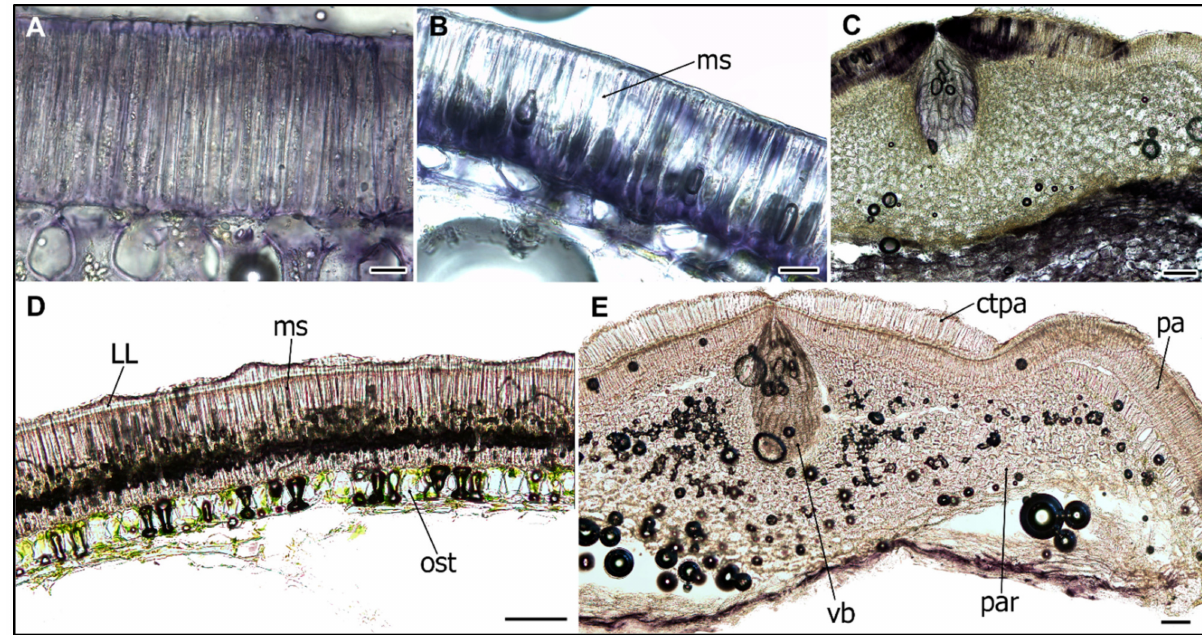
Figure 6. Histochemical localization of peroxidase activity in the pea seed coat. Cultivated pea ( Pisum sativum subsp. sativum ): cv. Cameor sampled at 13 DAA ( A ), and mature dry stage ( B ), hilum region at 25 DAA ( C ); wild pea ( Pisum sativum subsp. elatius ): JI1794 at 25 DAA ( D ) and hilum region of mature dry seed ( E ). Scale bars = 20 µ m ( A , B ) and 100 µ m ( C – E ). Abbreviations: ms—macrosclereid cells, ost—osteosclereids, par—parenchyma, ll—light line, vb—vascular